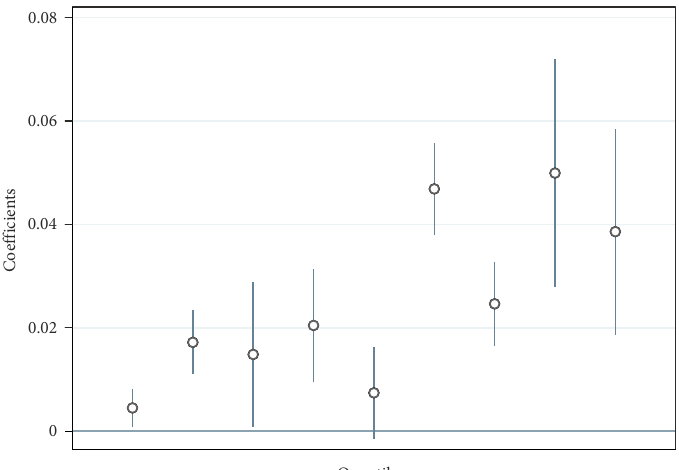
Figure 3. Heterogeneous effects across quantiles